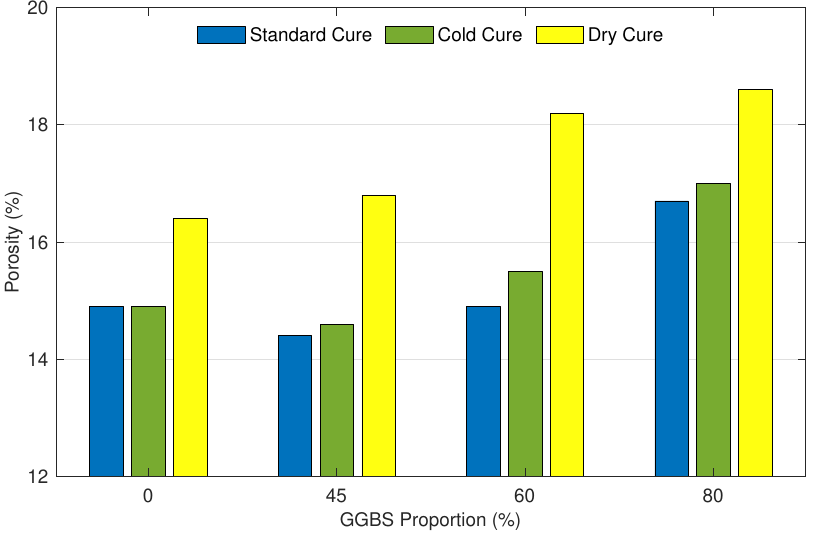
Figure 1. Porosity of mortar samples in function of their GGBS proportion and curing